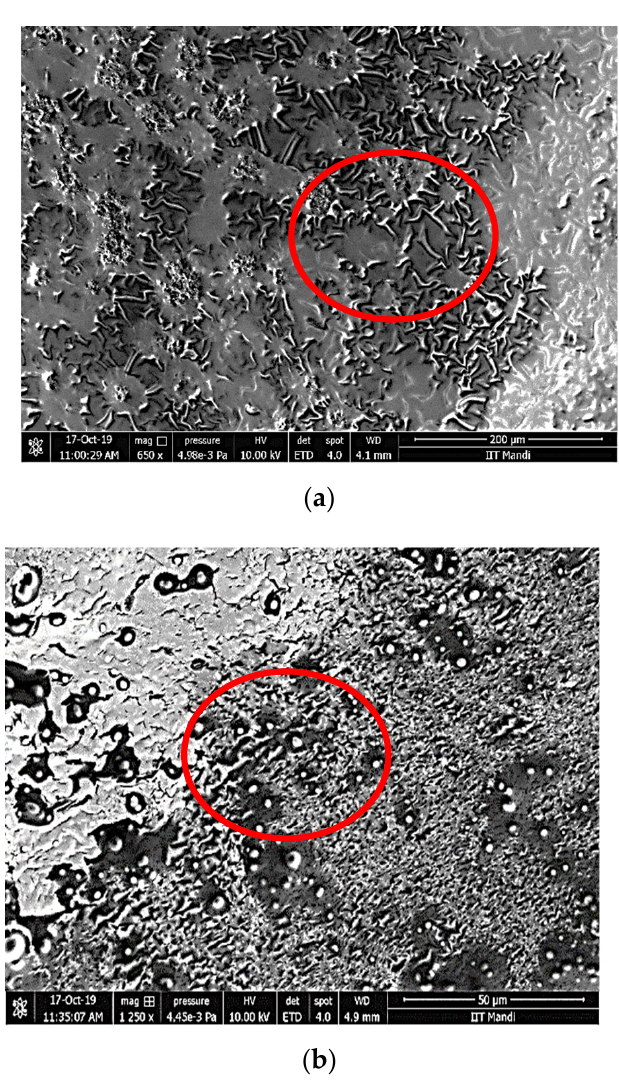
Figure 3. ( a ) Micrographs of control (650 × ) and ( b ) RRE5 (1250 × ) nanoemulsions indicating the smooth type and spherical nanoemulsion droplets. The presence of larger and smaller droplets in inconsequential proportions is described in different regions of the sample, which is common with nanoemulsions.